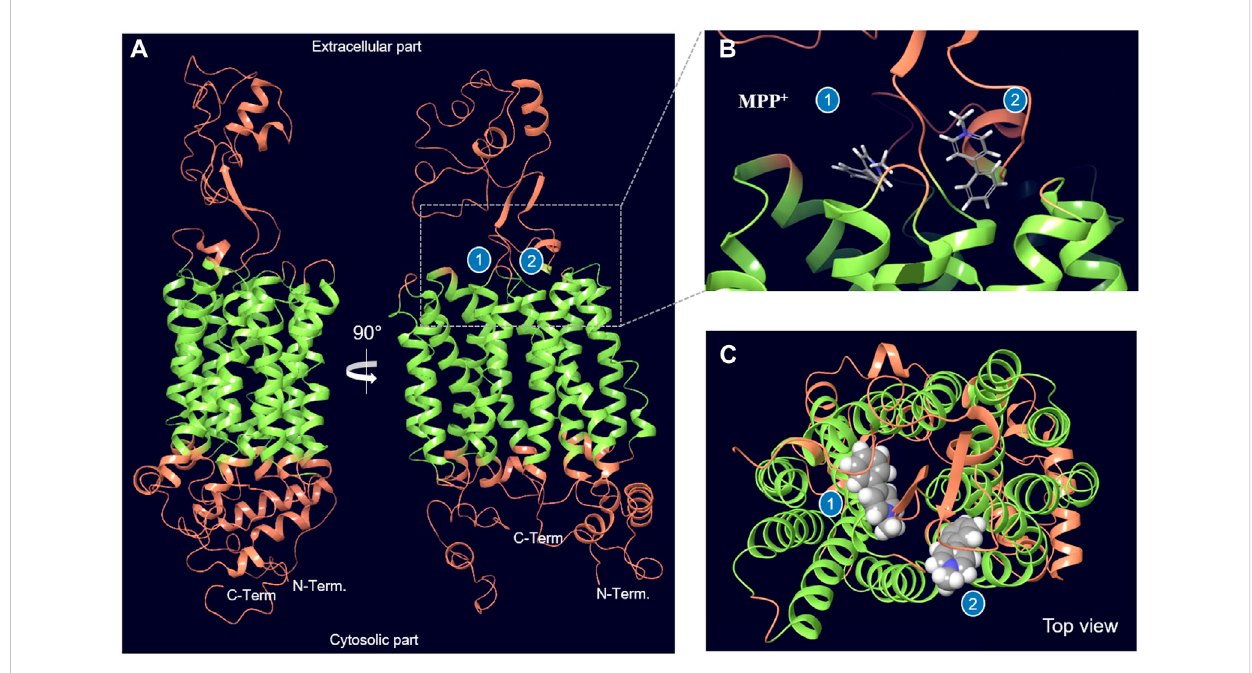
FIGURE 3 Optimized structural model of OCT2. Two distinct binding sites at the interface of the extracellular part and the transmembrane helices (in green) can be identi fi ed by docking of the model substate MPP+. The region of OCT2 that was used for docking is shown in Supplementary Figure S3. The estimated binding free energy for MPP+ in binding site 1 is – 54.1 kcal/mol and for binding site 2 is – 60.4